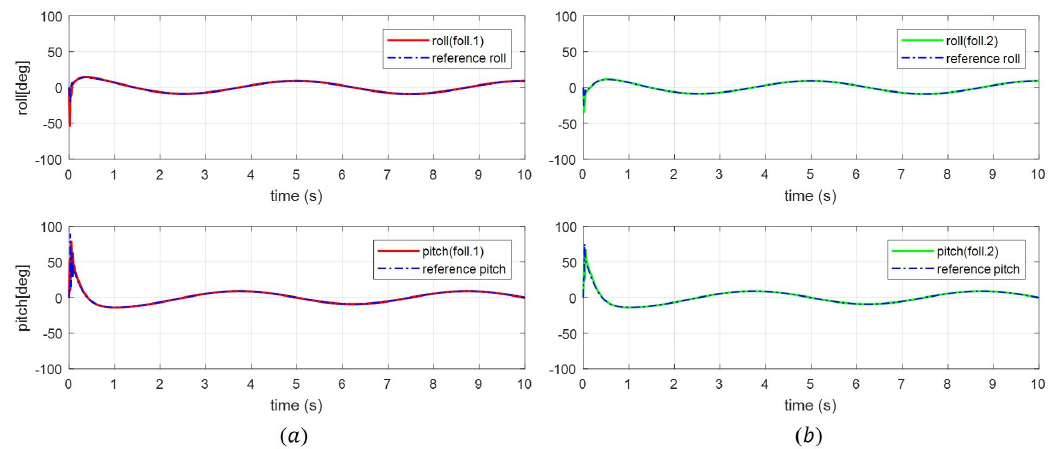
Figure 16. The reference angles of the follower quadrotors for the formation control about the 4 π circular trajectory: the dashed line indicates the reference attitude angles that enable the quadrotor to converge to the desired formation, and the solid line is the result of the simulation about attitude responses of the follower quadrotors. ( a ) Backstepping-based formation control with SAA; ( b ) proposed formation control with the state transformation technique (STT).